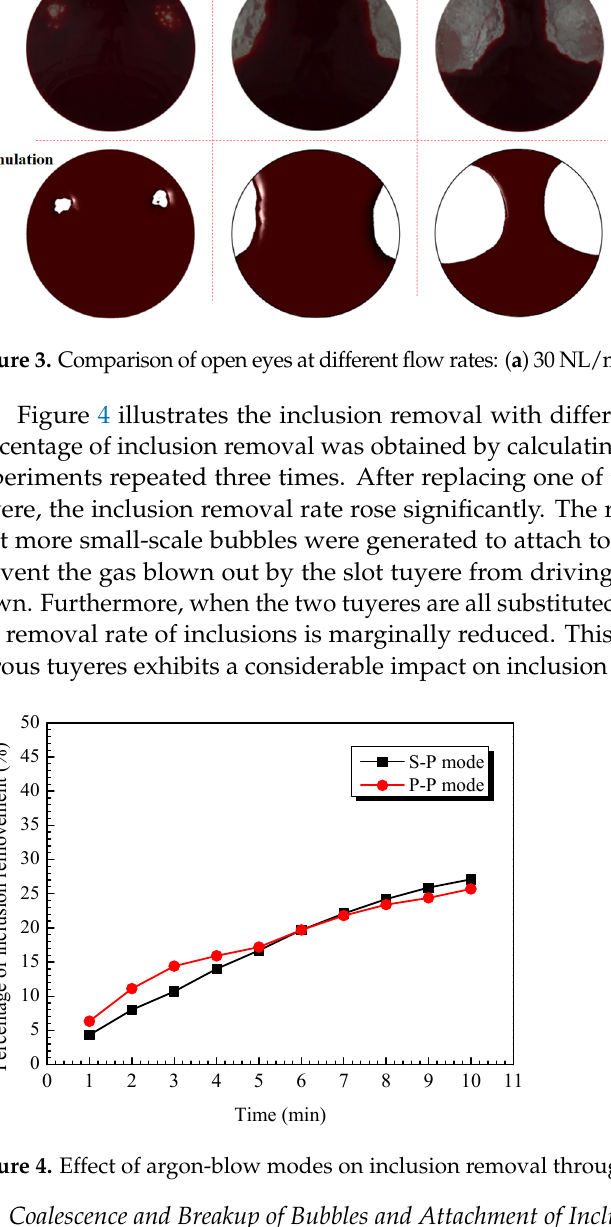
Figure 5. Bubbles coalescence and breakup. 3.3. E ff ect of Tuyere Matches on the Flow Field and Inclusion Transport Di ff erent from previous works, we proposed a new collection of tuyeres called slot– porous-matched dual tuyeres, and compared them with the traditional matches. Figure 6 illustrates the prediction of the fl ow fi eld as well as slag eyes for di ff erent tuyere matches. The velocity vectors are plo tt ed on the slag-metal interface in order to show the direction of fl ow path. According to Figure 6a, the fl ow fi eld in the conventional P–P mode is almost symmetrical and uniform, while after using the S–P mode, the fl ow fi eld becomes asym- metrical and uniform, just as displayed in Figure 6b. This implies that the S–P mode sig- ni fi cantly changed the fl ow fi eld in the ladle. As bubble size along the slot tuyere is larger than that on the porous tuyere side, the velocity along the slot tuyere side is also much larger than on the porous side, pushing more steel to move towards the porous tuyere